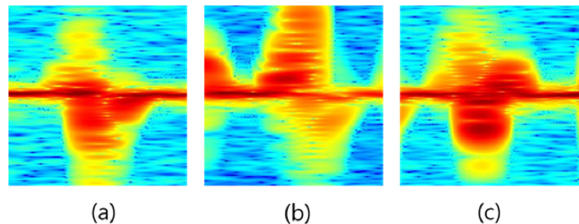
Figure 15. Spectrograms of multiple hand gestures: ( a ) spectrogram of the first hand gesture (right-to-left); ( b ) spectrogram of the second hand gesture (up-to-down); ( c ) spectrogram of the third hand gesture (finger stretch). Table 10. Computational time of methods.